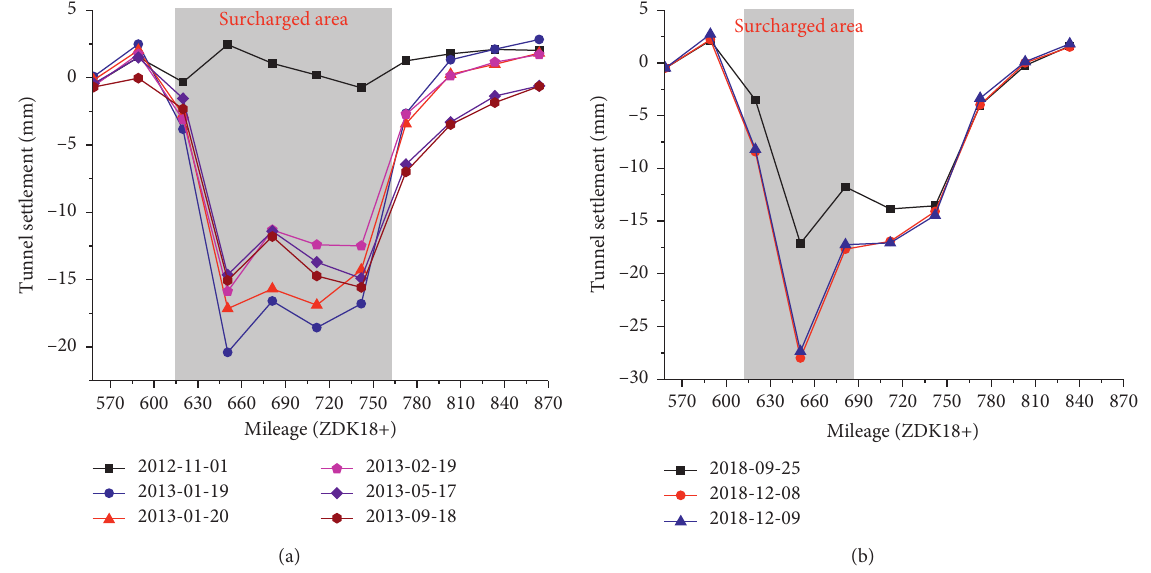
Figure 20: Tunnel settlement around the surcharged area. (a) First surcharge. (b) Second